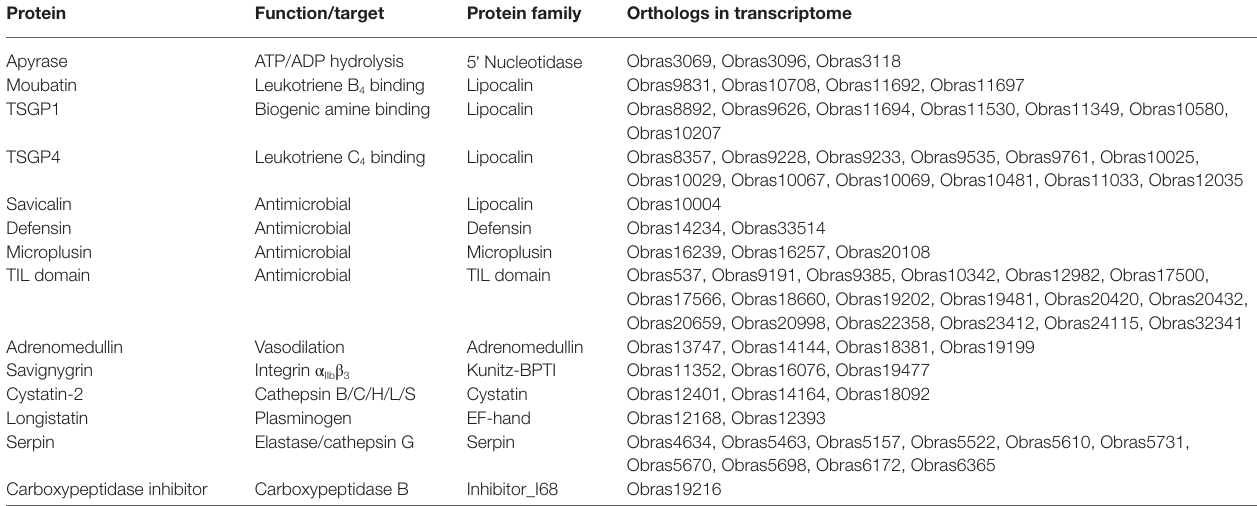
TABLE 1 | Orthologs for proteins with experimentally confirmed functions.